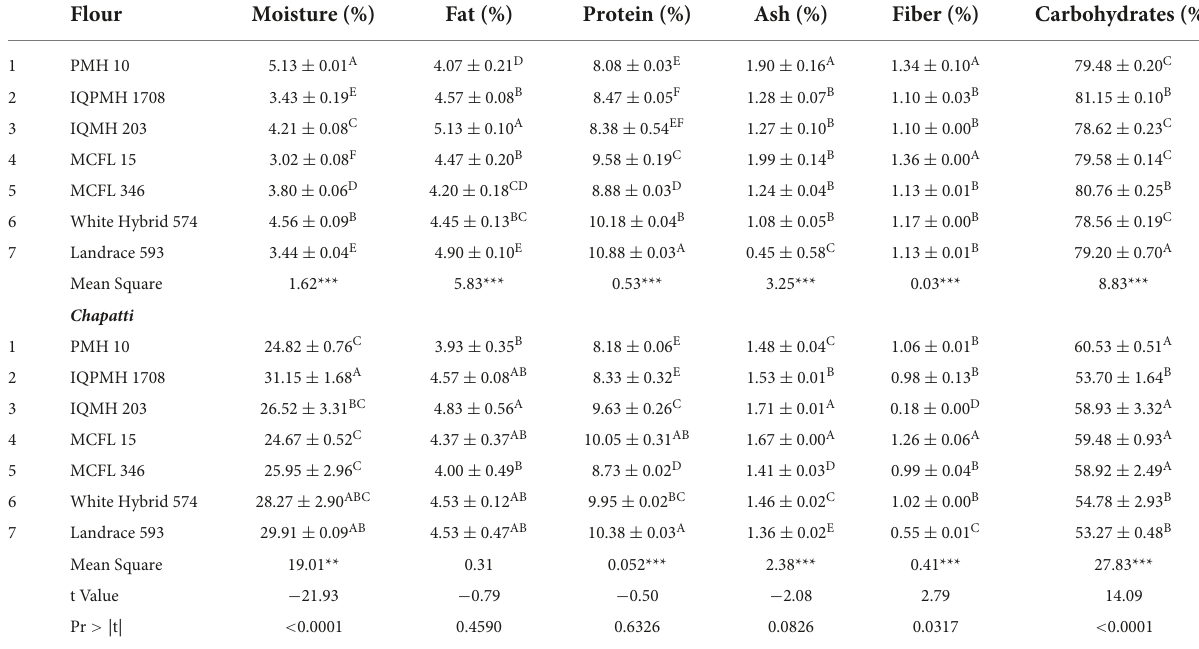
TABLE 3 Proximate composition of maize flour and Chapatti from different genotypes. Flour